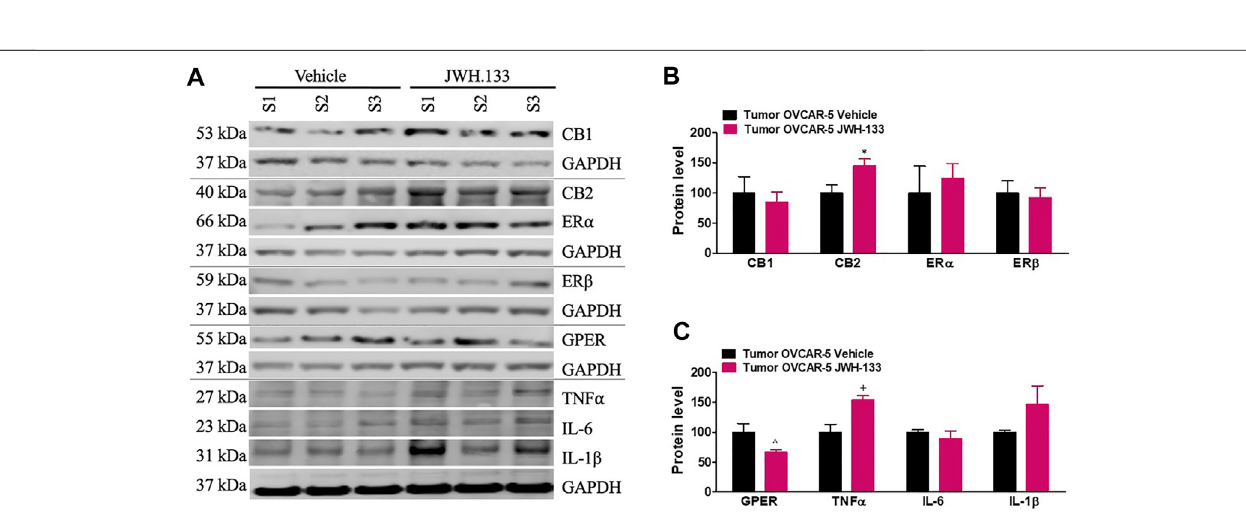
FIGURE 6 | Increase in CB 2 and TNF α but decrease in GPER protein levels in the OVCAR-5 ectopic xenograft tumors of SCID-SHO female mice receiving chronic systemic administration ofJWH-133. JWH-133 (1 mg/kg i.p.) chronic administration for 30 days starting on day 30oftumor growth produced an increase in CB 2 (A, B) and TNF α (A, C) protein levels in the OVCAR-5 ectopic xenograft tumors of SCID-SHO female mice relative to the vehicle treated group. However, a decrease in GPER (A, C) protein levels was in the OVCAR-5 ectopic xenograft tumors of SCID-SHO female mice receiving chronic administration of JWH-133 relative to vehicle group. Symbols represent the means ± SEM. (OVCAR-5 tumors in SCID-SHO female mice receiving vehicle, n = 3 – 6 SCID-SHO females; OVCAR-5 tumors in SCID- SHO female mice receiving JWH-133, n = 3 – 6 SCID-SHO females). * p < 0.033 unpaired t-test (t 4 = 2.50, one-tailed); ^ p < 0.0058 unpaired t-test (t 7 = 3.387, one-tailed); + p < 0.0117 unpaired t-test (t 4 = 3.568, one-tailed).